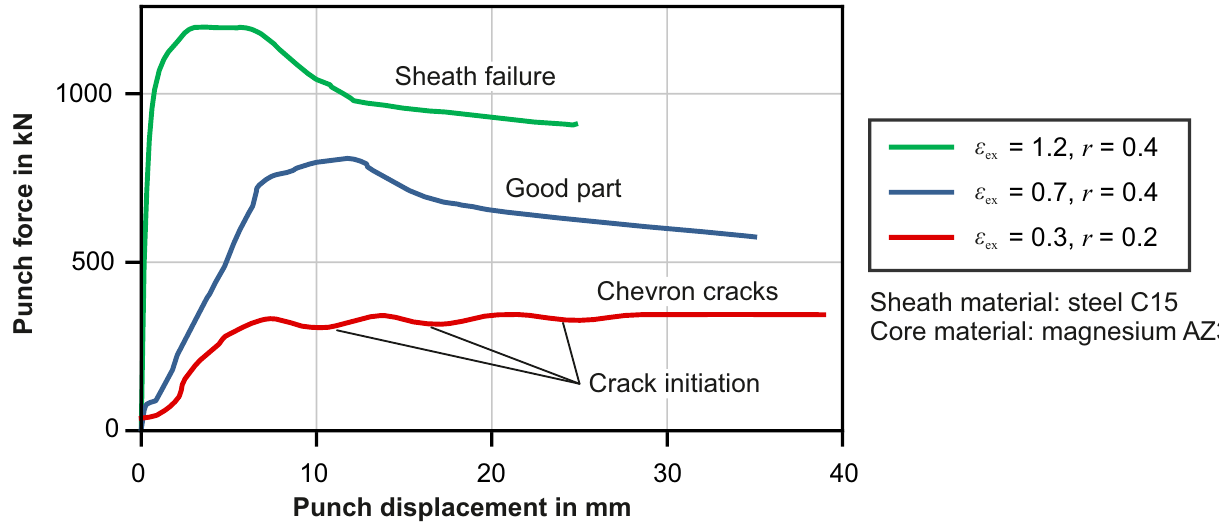
Figure 6. Punch forces in magnesium-steel composite forward rod